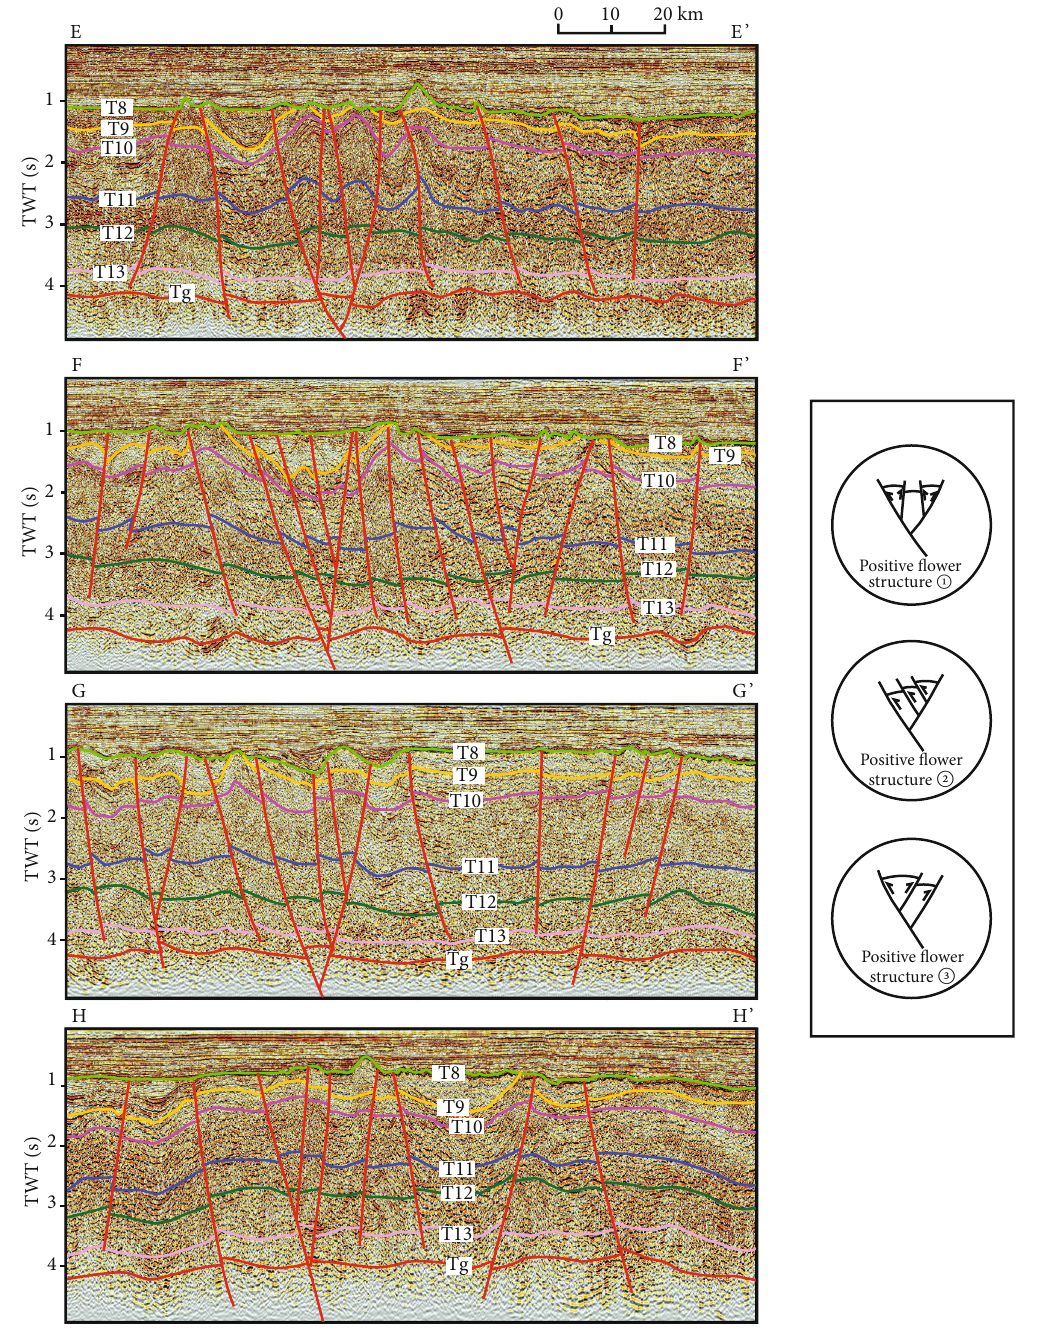
Figure 6: Characteristics of the strike-slip structure in the seismic section of the Wunansha Uplift, South Yellow Sea basin (see Figure 1 for pro fi le